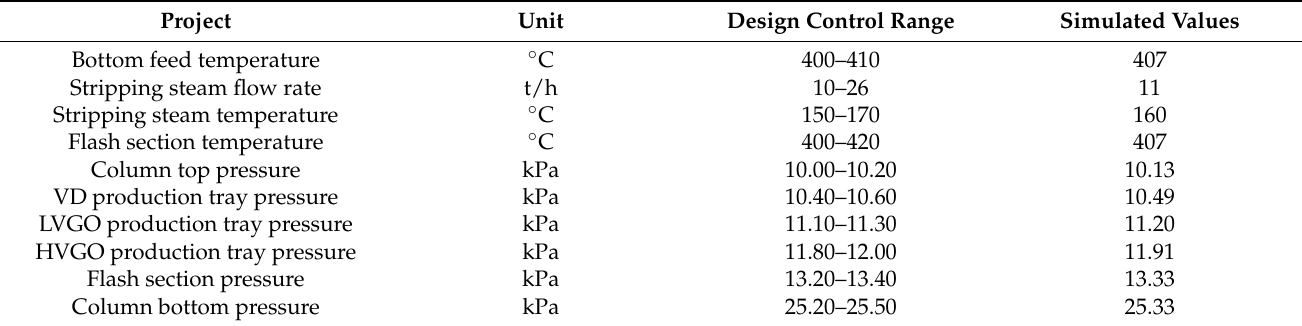
Table 4. Comparison between design and simulation values of operating parameters.